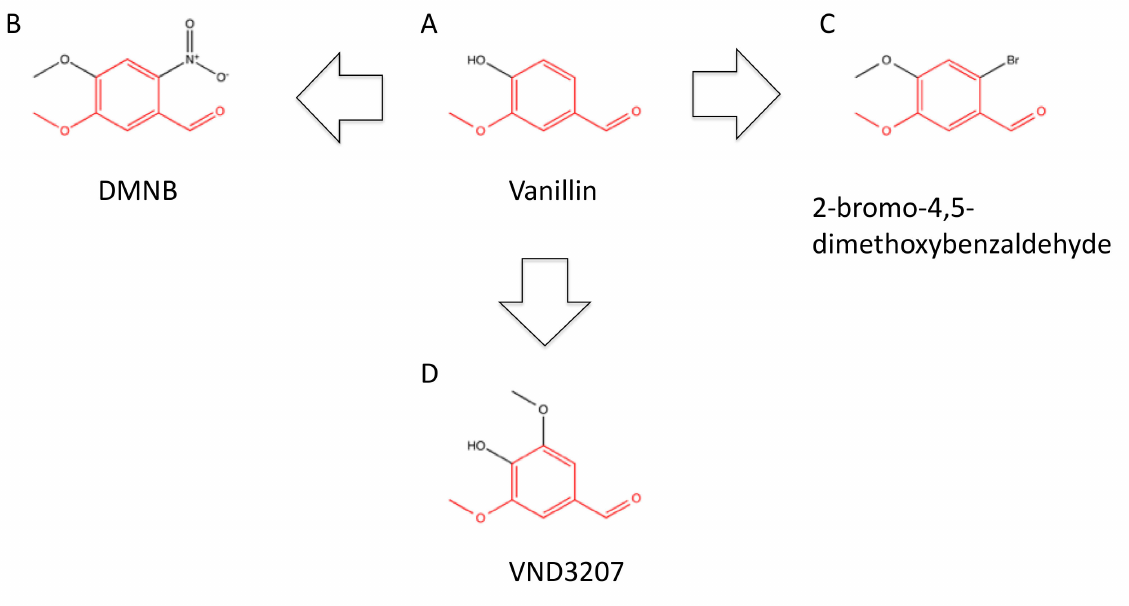
Figure 7. Structure of vanillin-based inhibitors. ( A ) vanillin, ( B ) DMNB, ( C ) 2-bromo-4,5- dimetoxybenzaldehyde, ( D ) VND3207. Meta-methoxy benzaldehyde structures, which are common to all the compounds, are highlighted in